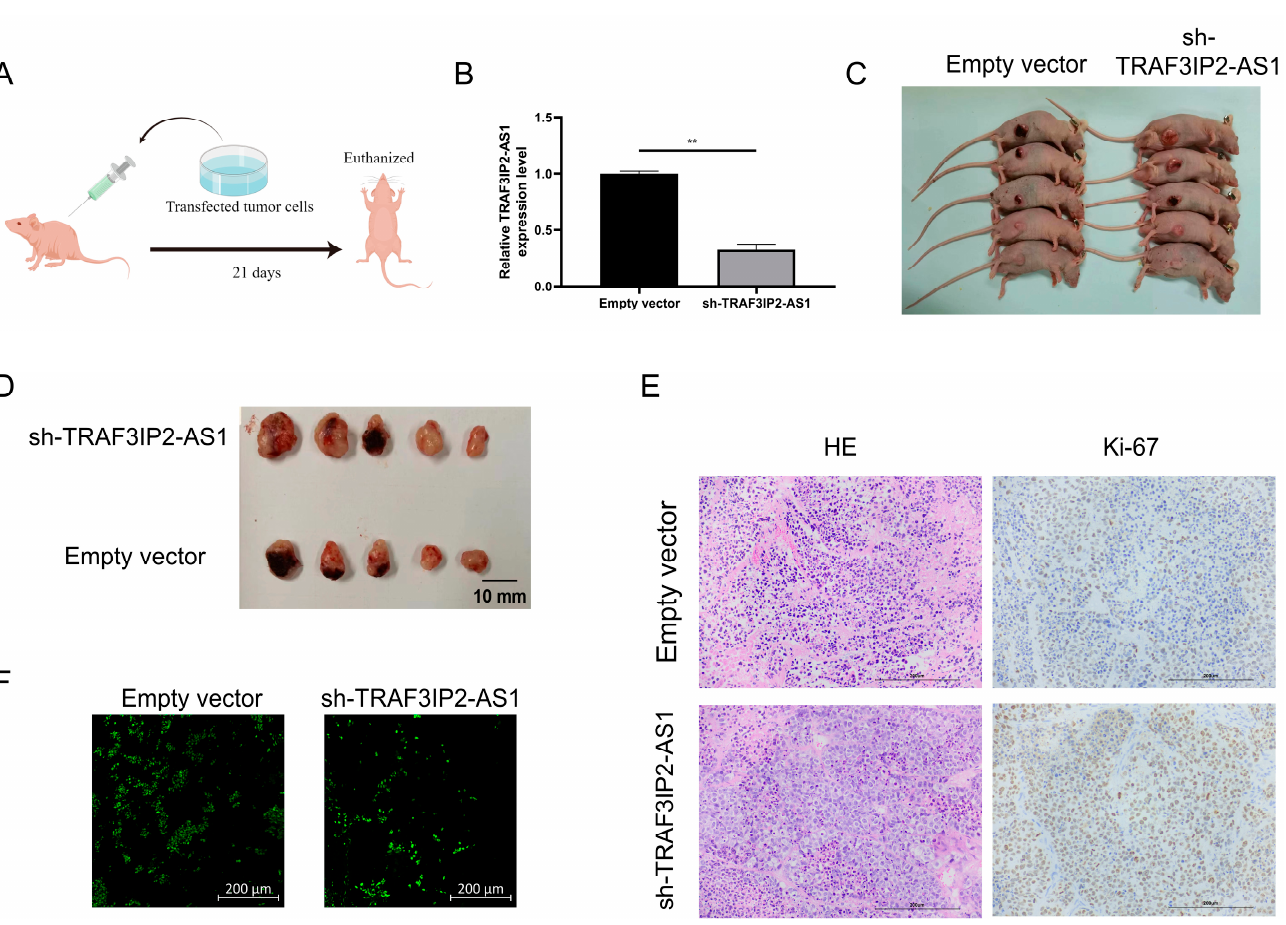
Figure 7. TRAF3IP2-AS1 inhibited PDAC progression in vivo. ( A ) Procedure of the in vivo experiment. ( B ) The knockdown efficacy of shRNA was proved by qRT-PCR. ( C ) Mice were euthanized 21 consecutive days after the subcutaneous injection of transfected tumor cells. ( D ) Tumors were harvested from the mice after 21 consecutive days. ( E ) Ki-67 staining showed that the proliferation was more vigorous in tumor specimens from the knockdown group. ( F ) TUNEL staining showed that the rate of apoptosis was lower within the tumor lesions from the knockdown group. ** p < 0.01.